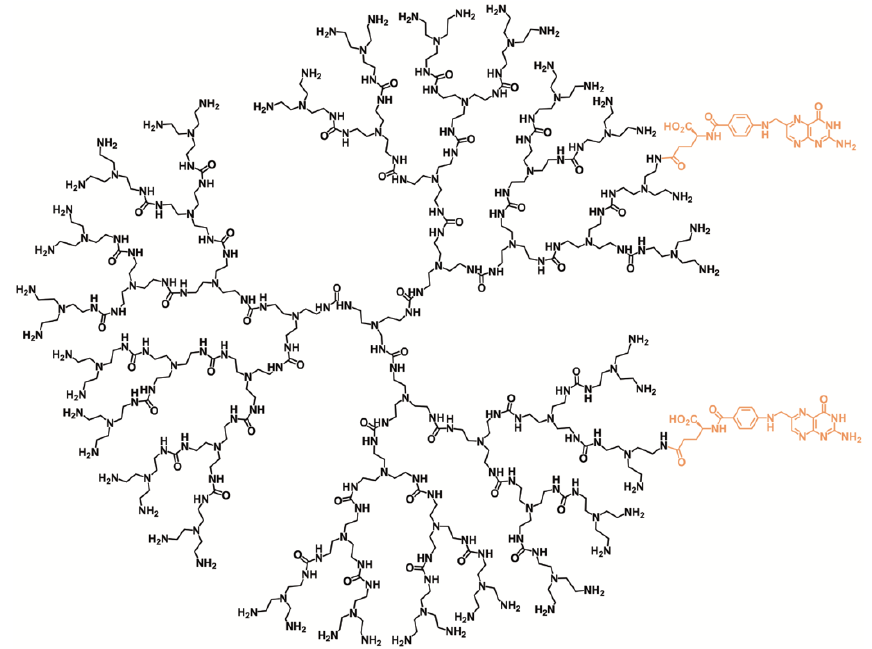
Figure 2. Chemical structure of the L -Buthionine sulfoximine ( L -BSO) nanocarrier, generation four polyurea dendrimer targeted with folic acid (PURE G4 -FA 2 ).